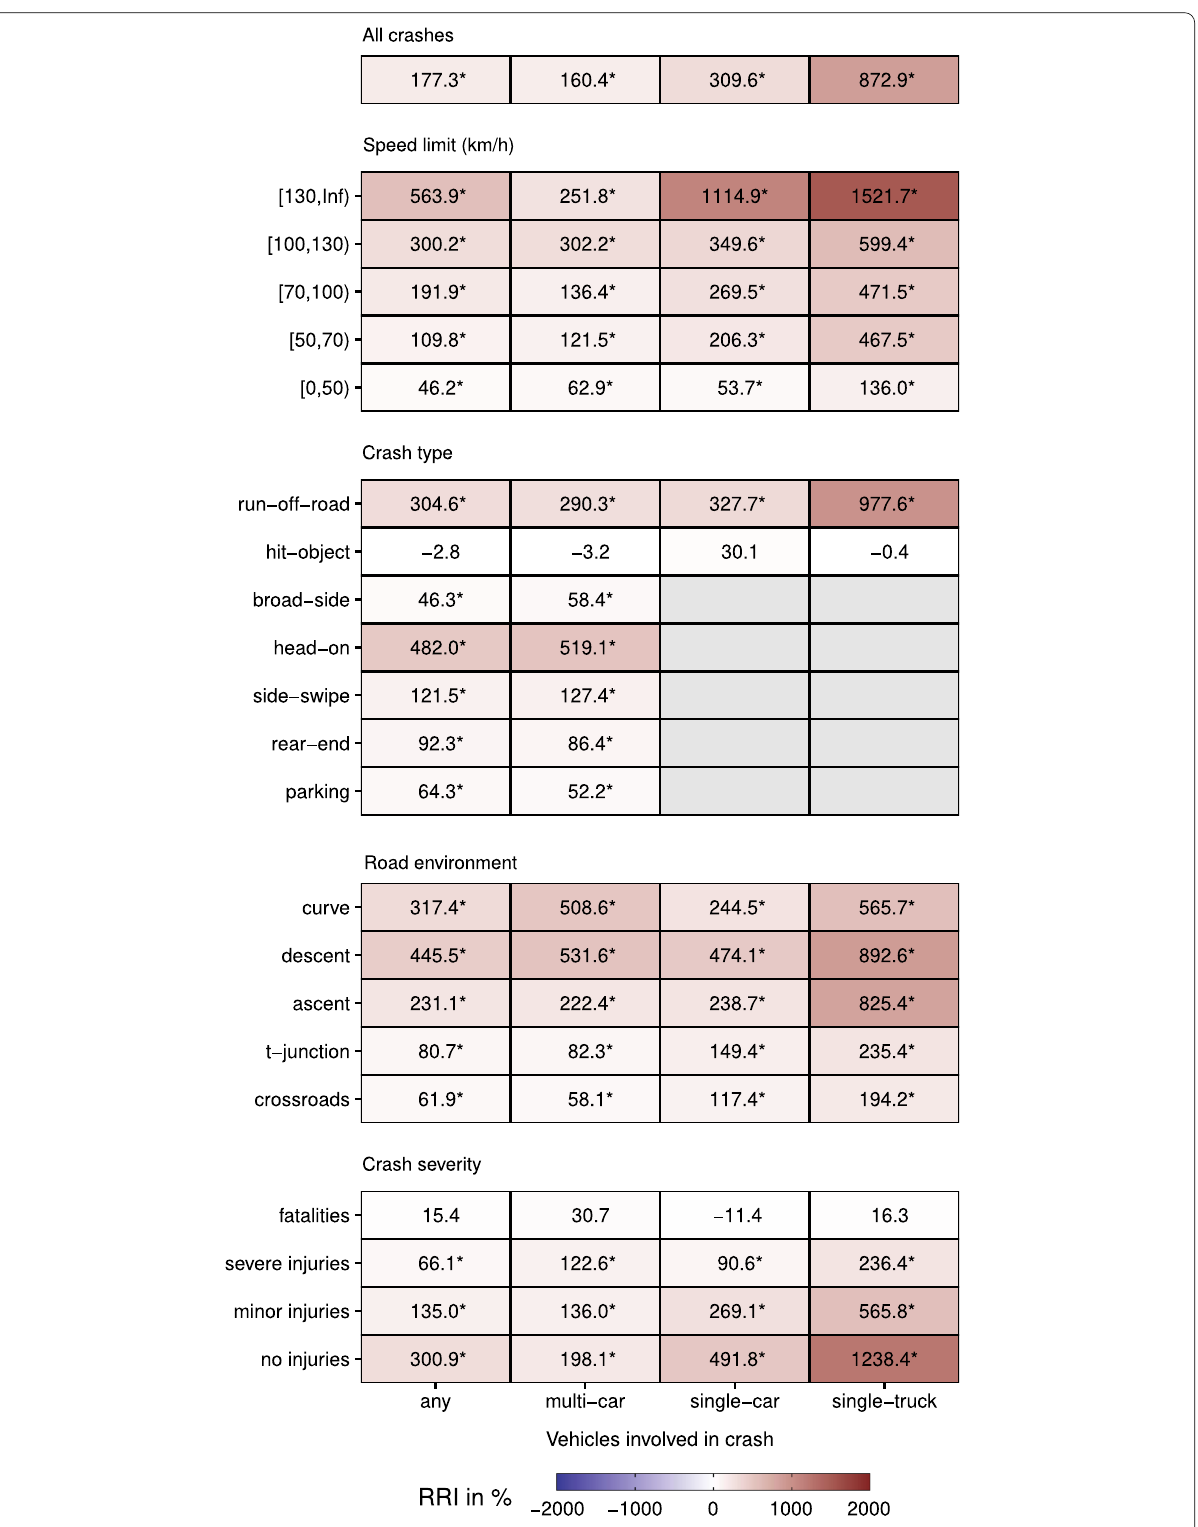
Fig. 3 Relative risk increase (RRI) of crash probabilities in situations with precipitation and negative temperature ( Tmp = − 3 ◦ C and Prc = 1 mm/h) compared to situations without precipitation and positive temperatures ( Tmp = + 3 ◦ C and Prc = 0 mm/h). Significant changes (i. e. more than 95 of 100 models fitted with randomly drawn training data show the same direction of change) are indicated with an